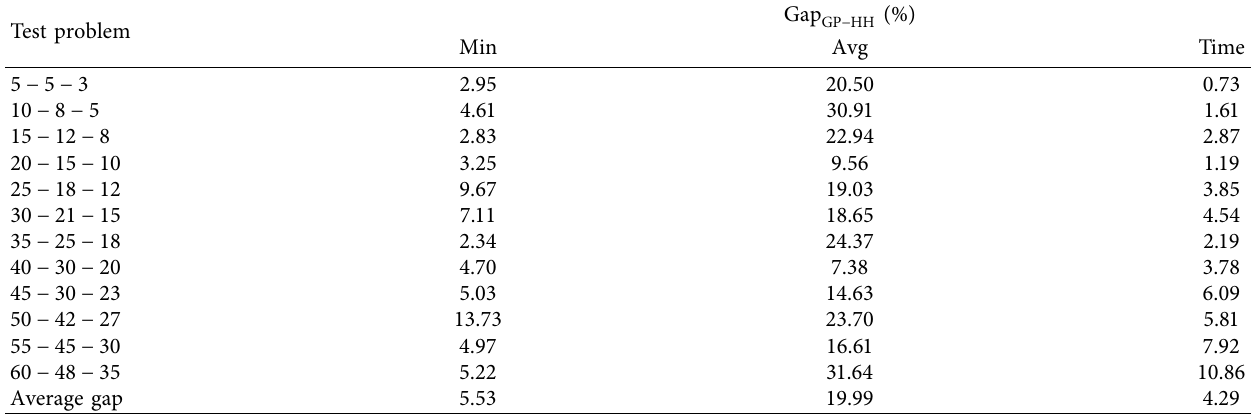
Table 7: Comparison with GP-HH.